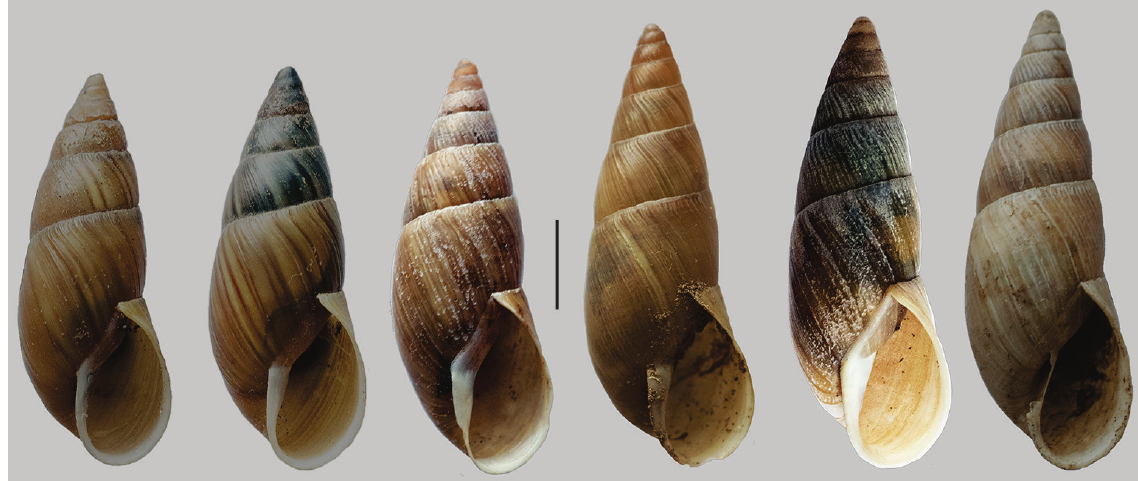
Figure 1. Shell morphology of Ventania avellanedae : general view showing shell variability and teleoconch striation. Scale bar: